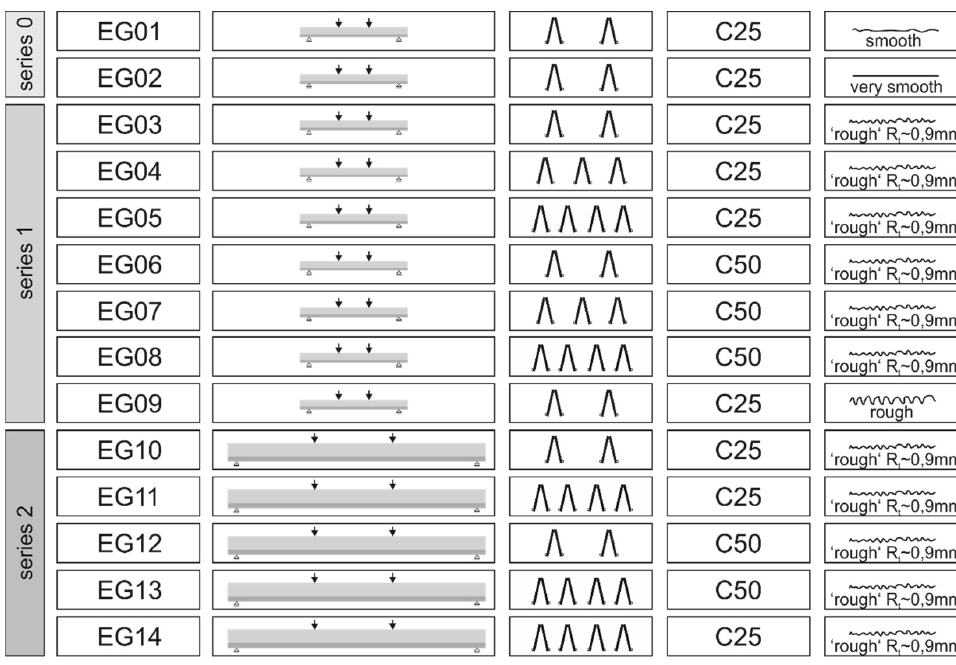
Figure 11. Schematic test setup of fatigue tests: Sub-Test I ( a ) and Sub-Test II ( b ).